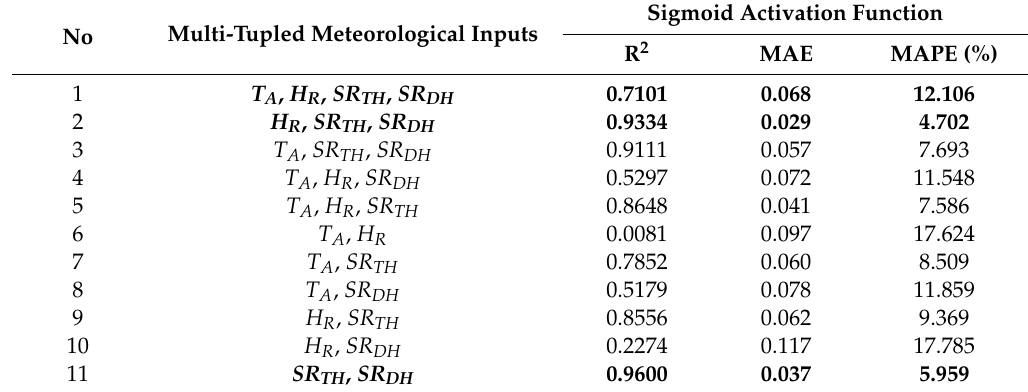
Table 3. Daily photovoltaic power prediction results of the ALO-MLP method, which used the sigmoid activation function.